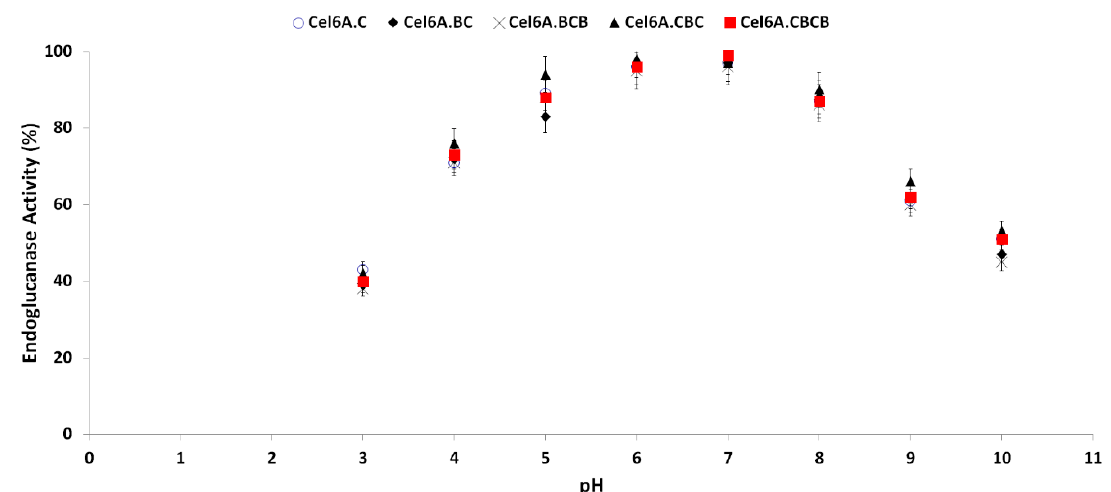
Figure 4. E ff ect of pH on hydrolytic activity against CMC of cel6A Figure 4. Effect of pH on hydrolytic activity against CMC of Cel6A variants.